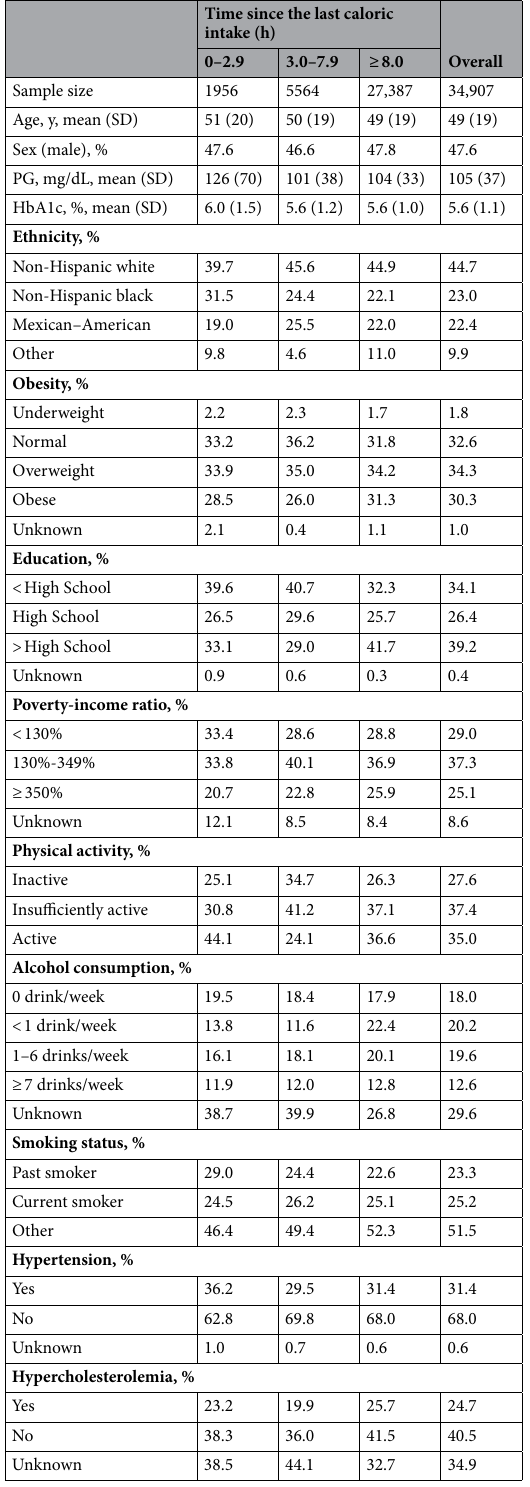
Table 1. Baseline characteristics of the cohort of 34,907 participants. HbA1c, hemoglobin A1c; PG, plasma glucose; SD, standard